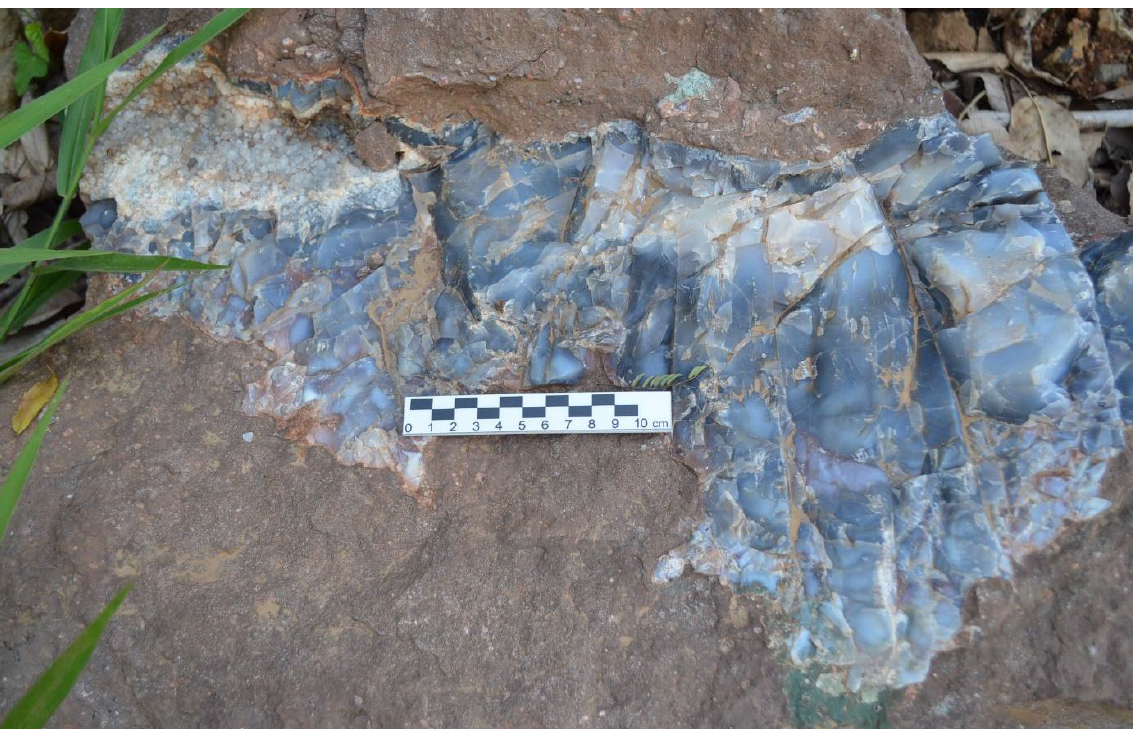
Figure 11. Chalcedony outcrop included in the basalt (Alto Bela Vista County, Santa Catarina